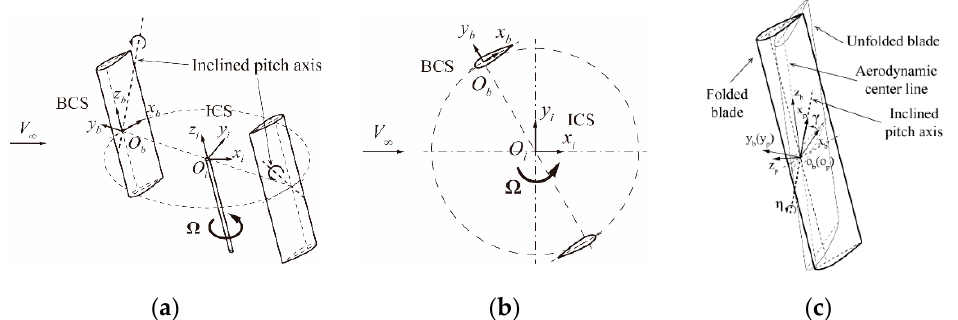
Figure 1. Different coordinate system arrangements: ( a ) inertial coordinate system (ICS) and unfolded blade coordinate system (BCS); ( b ) top view of the ICS and BCS; and ( c ) BCS and inclined pitch axis coordinate system (PCS) [4].